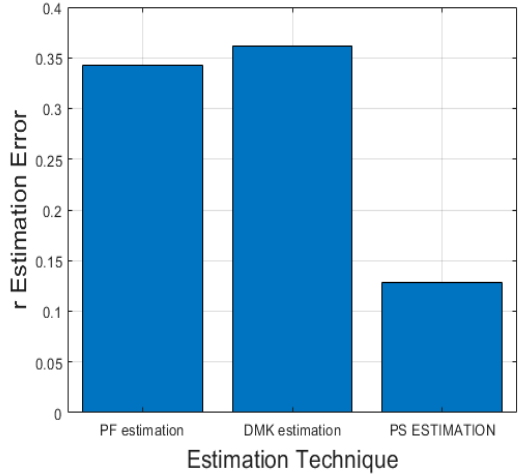
Figure 10. Average RMSE obtained for the measurement of r n .